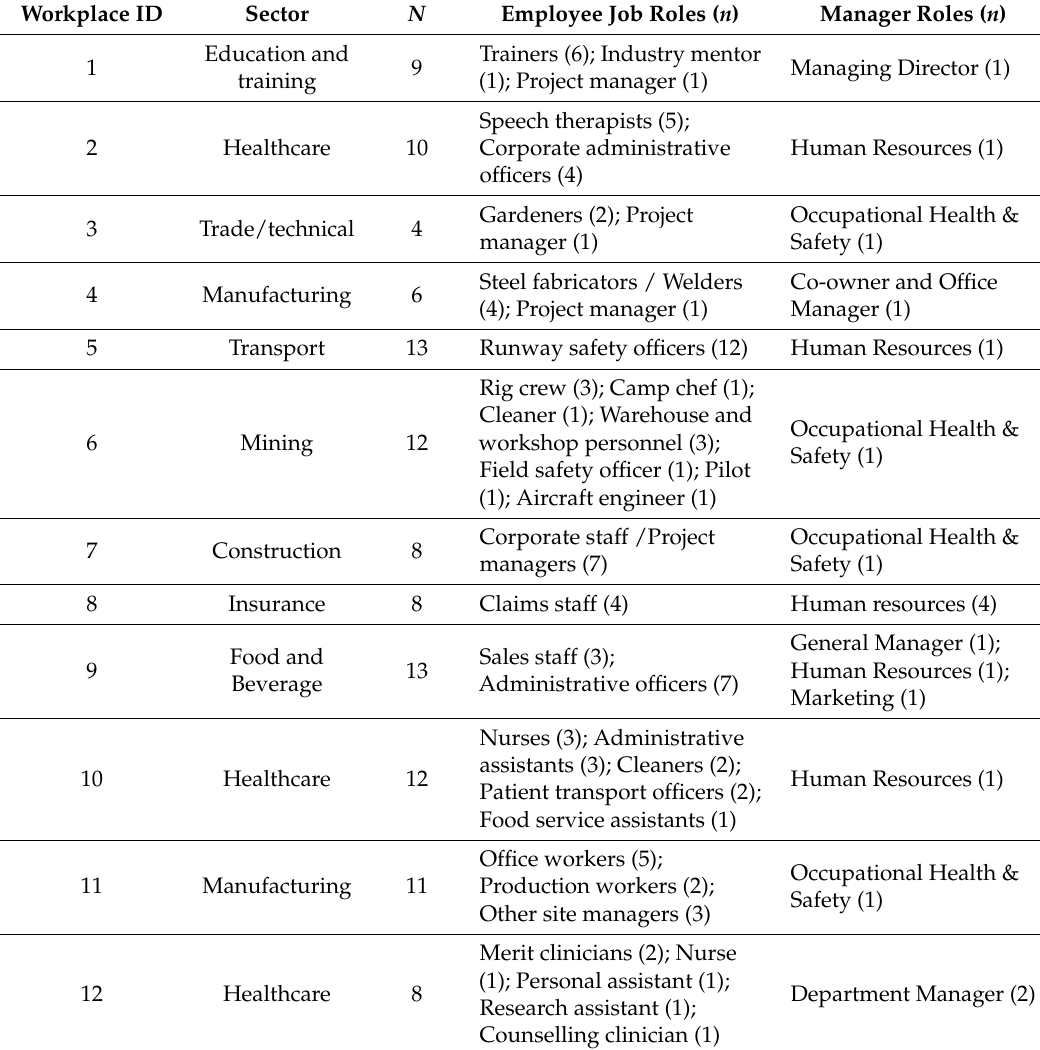
Table 1. Industry sector and occupations of study